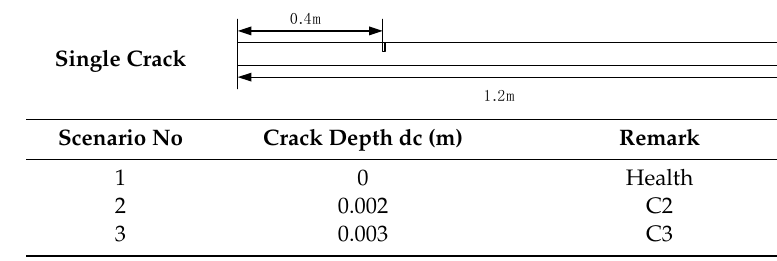
Figure 5. The crack form of the pipeline. Table 4. The tested scenarios.